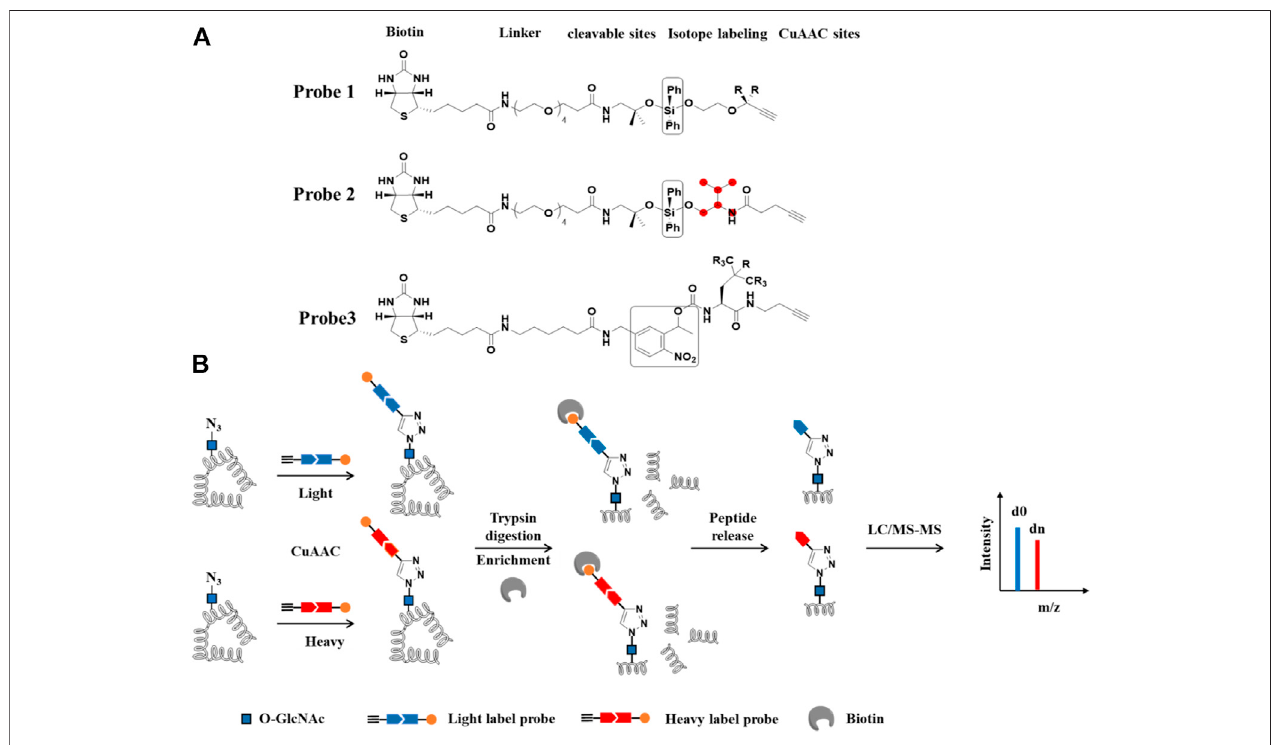
FIGURE7| IsoTaG-basedquantitativeproteomics forpro fi lingofprotein O-GlcNAc modi fi cation. (A) Structures ofprobes.Rand red ballsrepresentheavy orlight labelingsites.Blackboxrepresentscleavablegroups (B) Work fl owofdifferentiallabelingandquantitativeanalysisofO-GlcNAcylatedproteins.O-GlcNAcylatedproteins fi rst are labeled with azide group by Metabolic labeling or chemoenzymatic strategies. Isotope probes are added to O-GlcNAcylated proteins via CuAAC reaction, followed by incubation with streptavidin beads. The proteins on the beads are digested with trypsin and O-GlcNAcylated peptides are released by cleavable sites and analyzed by